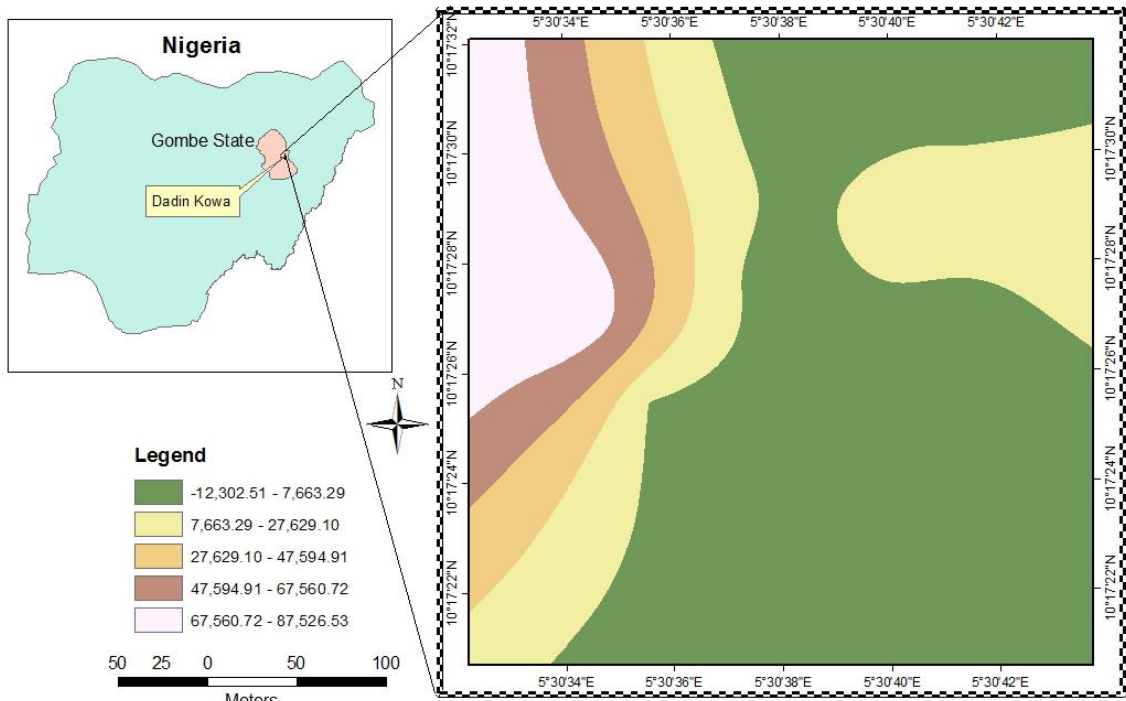
Fig. 6. Aquifer transverse resistance across the floodplain.